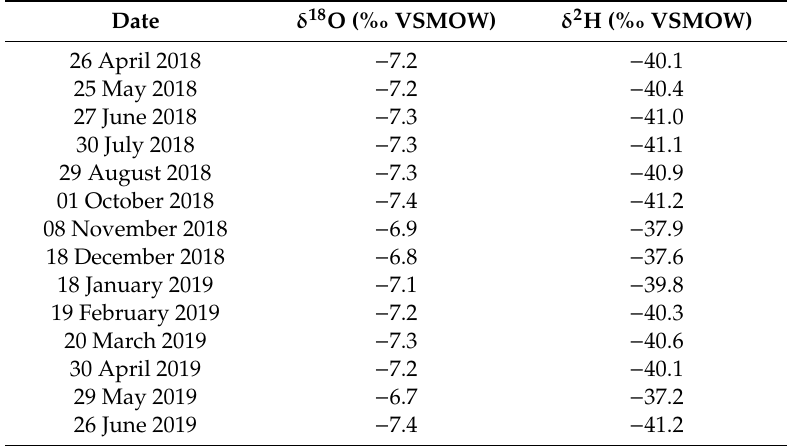
Table 1. Isotope composition of spring water samples collected from May 2018 to June 2019.